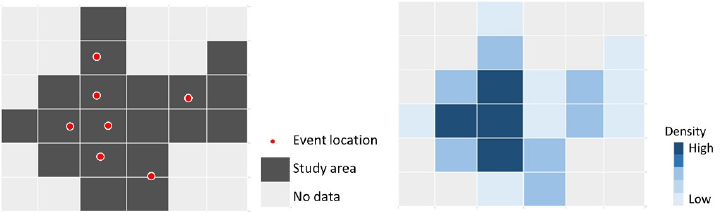
Figure 1. An illustration of KDE input ( left ) and output ( right ). Probability densities are estimated at raster cells that are within the study area, except for no-data cells.